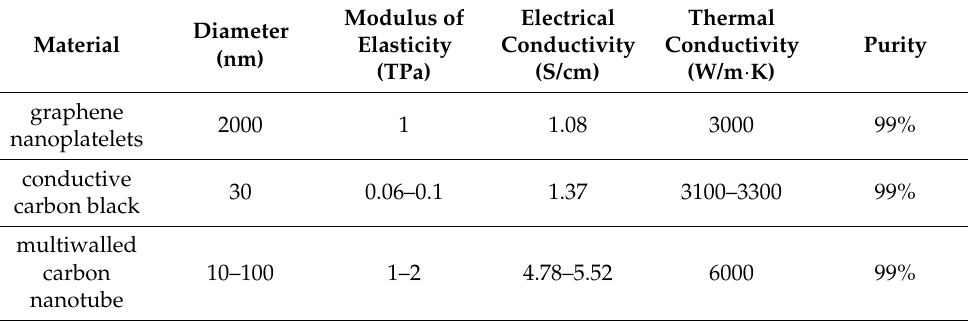
Table 1. Properties of the nanomaterials (by Ditto Co., Ltd., Seoul, Korea).